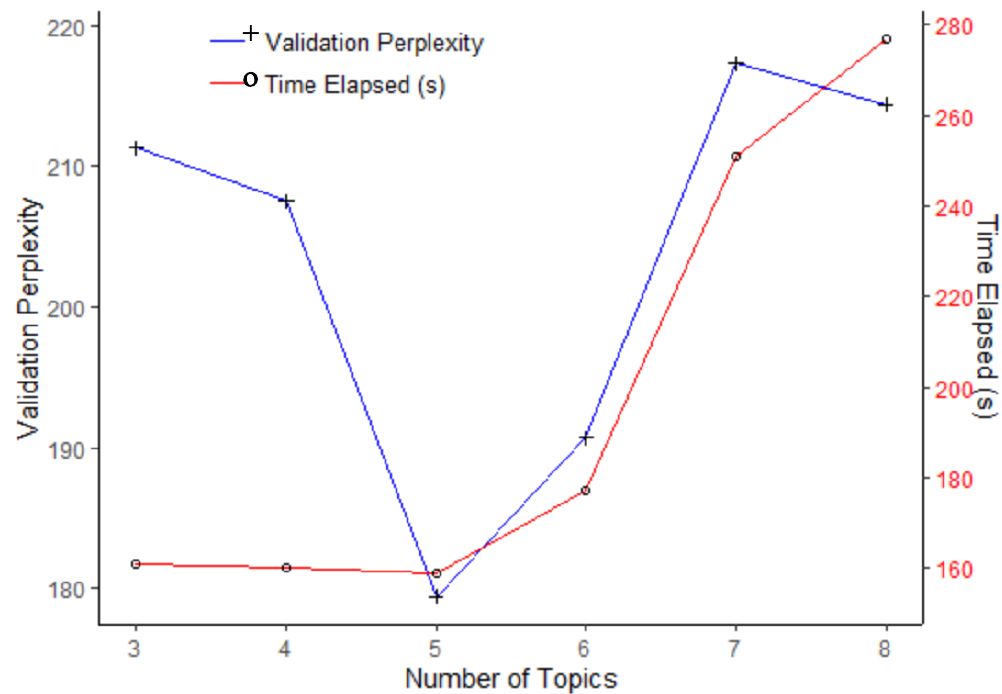
Figure A1. Perplexity vs. number of topics for the laser welding study.